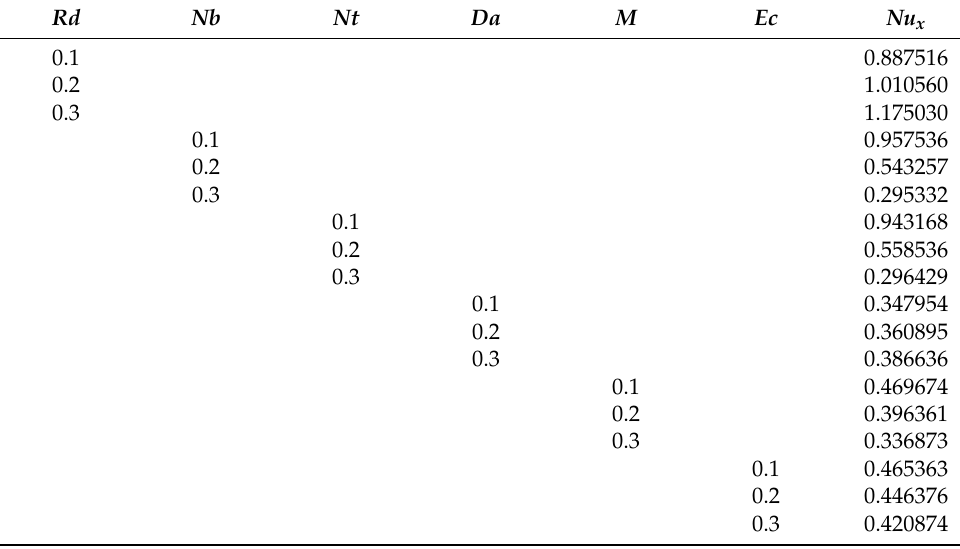
Table 3. Numerical values of local Nusselt number via different embedded factors.